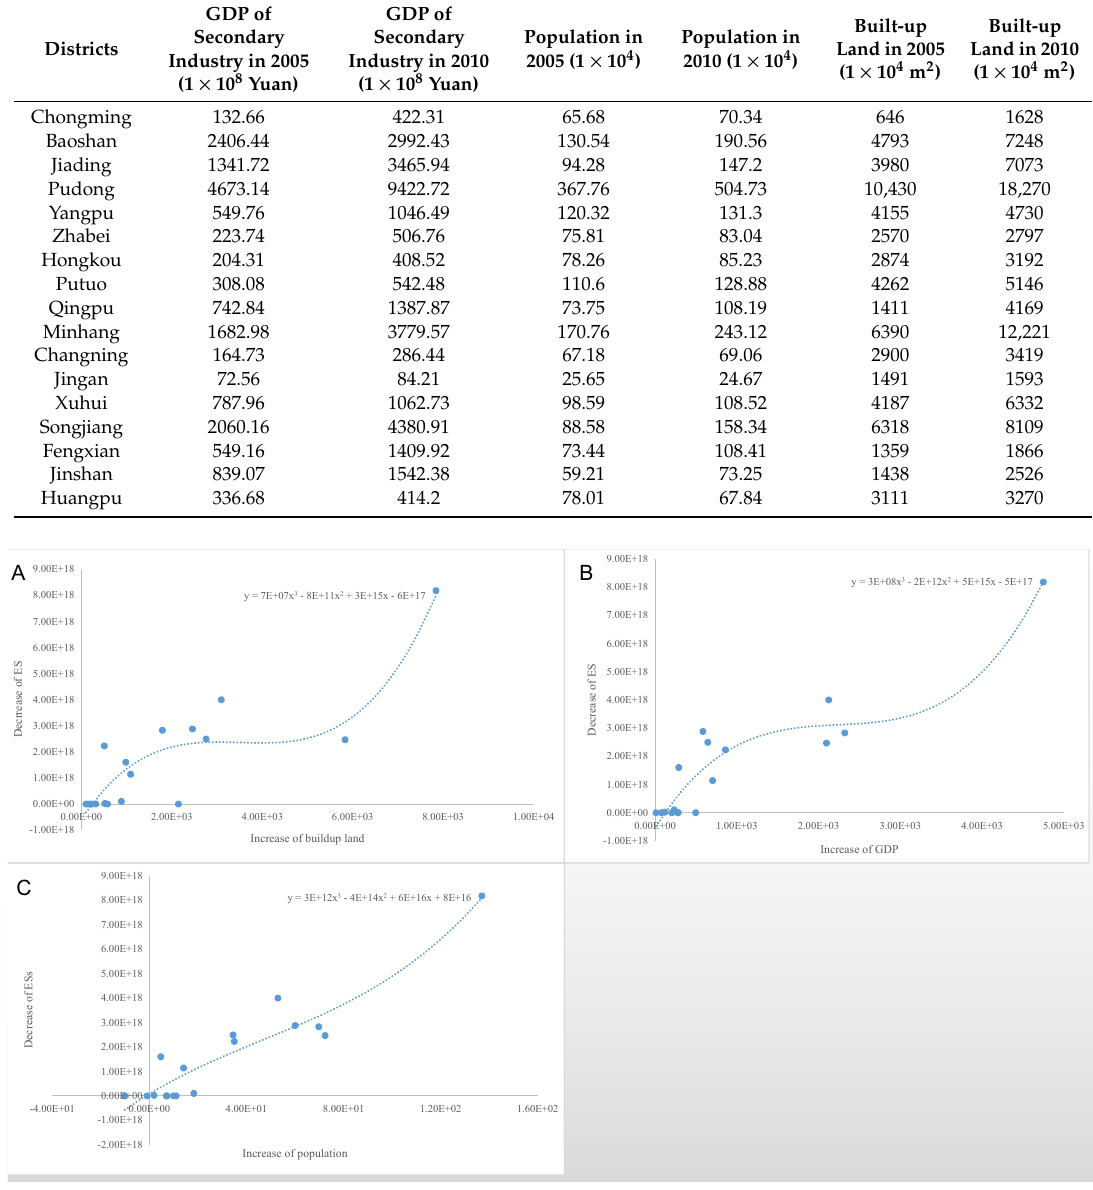
Figure 16. Relationships between the decrease of total ESs and urbanization indicators. ( A ): built-up land vs. ESs, ( B ): GDP vs. ESs, ( C ): population vs.